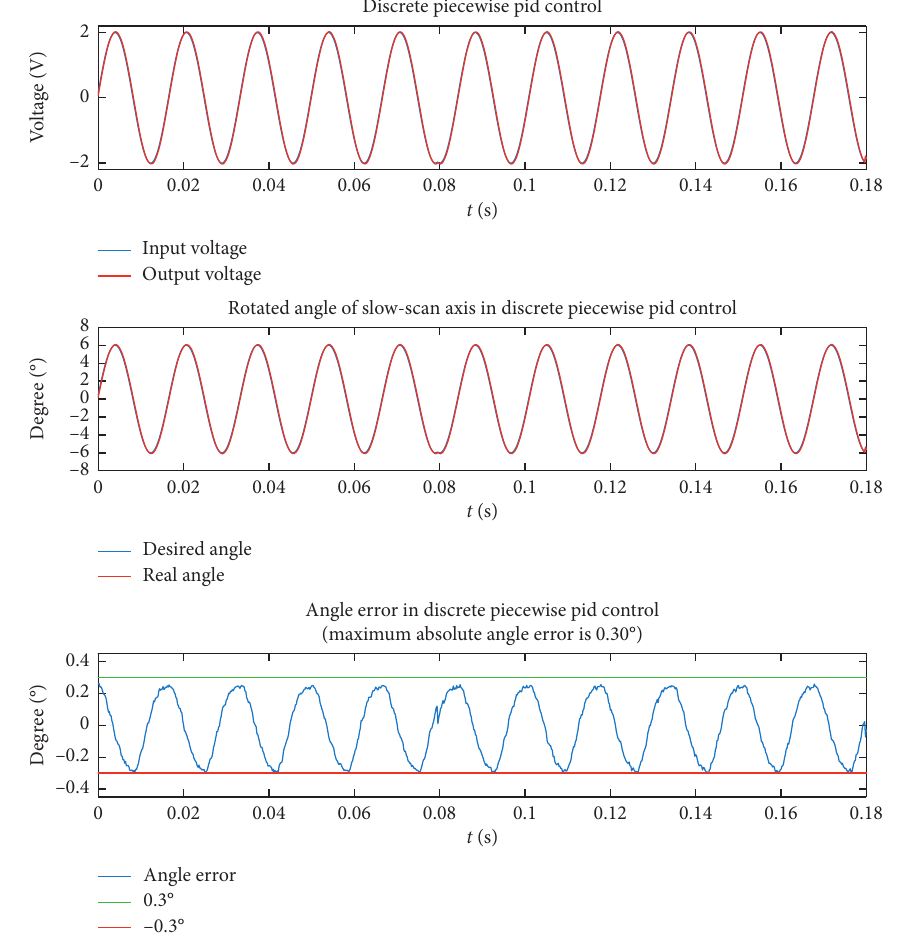
Figure 9: Slow-scan axis control of electromagnetic micromirror in discrete piecewise PID